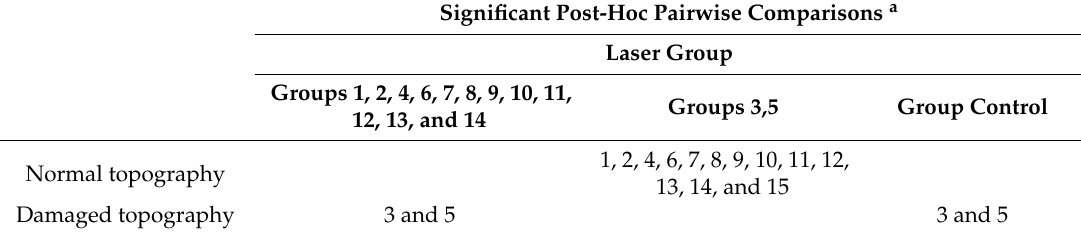
Table 3. Statistically significant post-hoc pairwise comparisons for the association between the presence of normal enamel topography and laser (n =